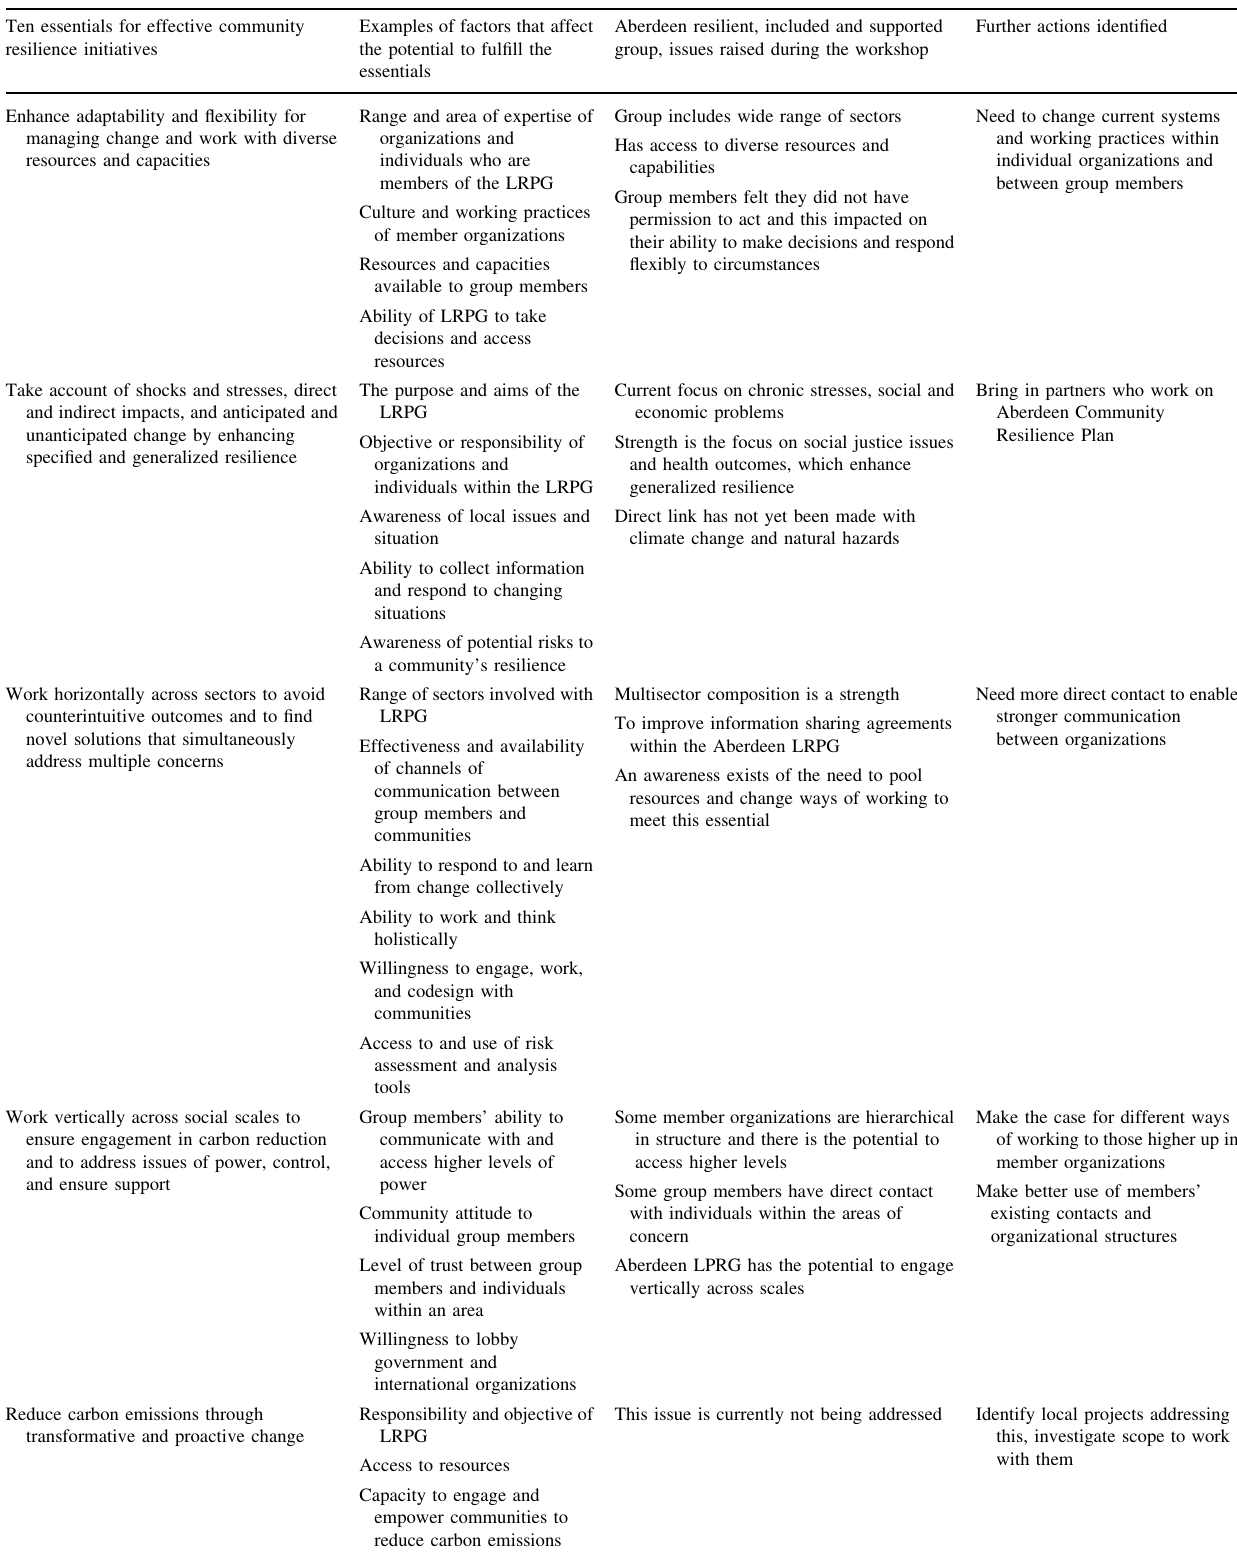
Table 3 Factors and issues of relevance to each of the 10 essentials for effective community resilience initiatives (Fazey et al. 2018, p. 31) using the example of the Aberdeen LRPG Ten essentials for effective community resilience